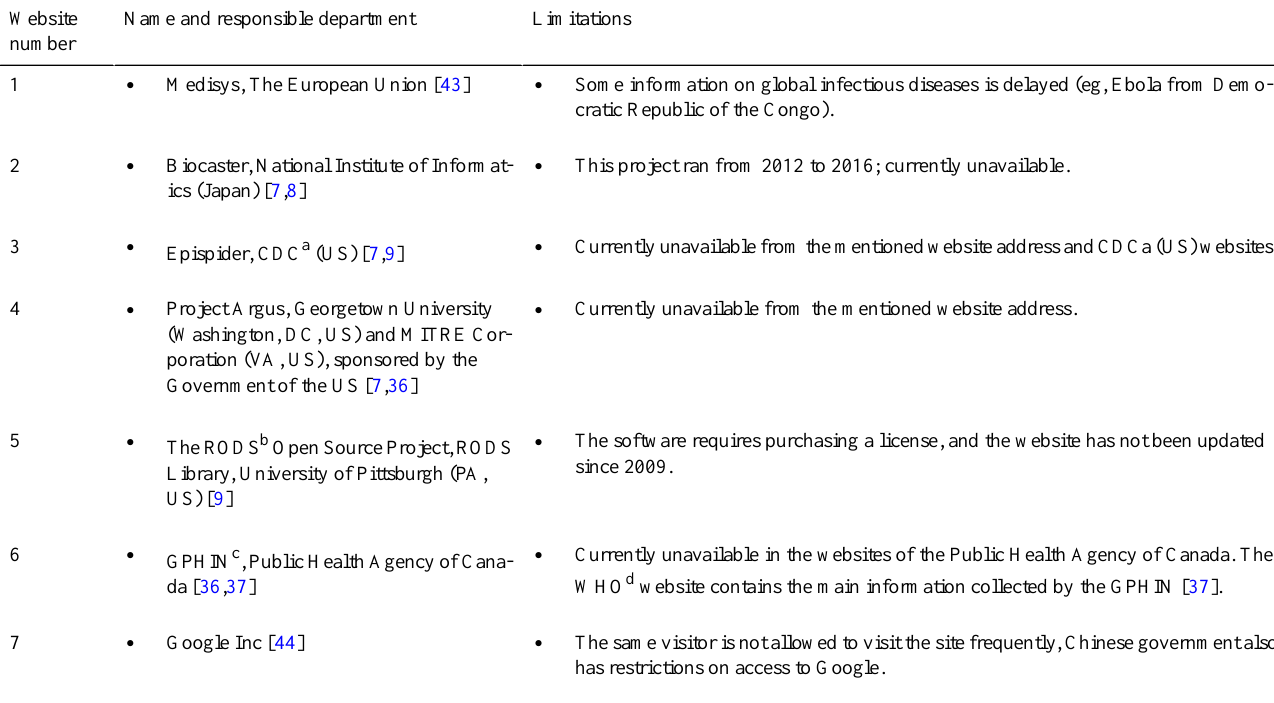
Table 2. Established and/or official public websites not used in the Global Infectious Diseases Epidemic Information Monitoring